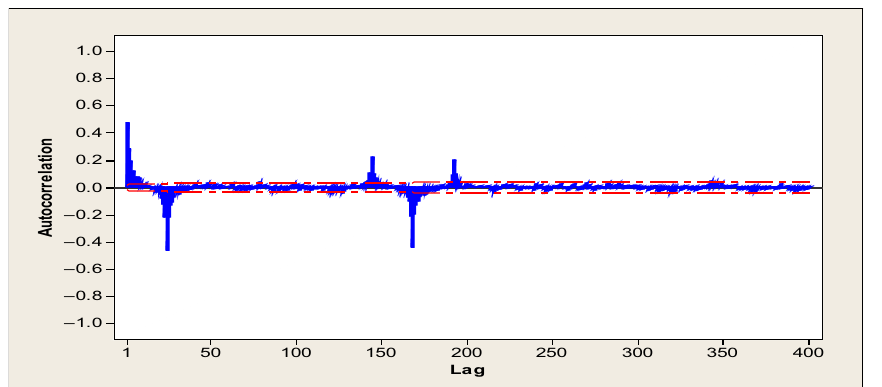
ACF of the Egyptian consumption after the